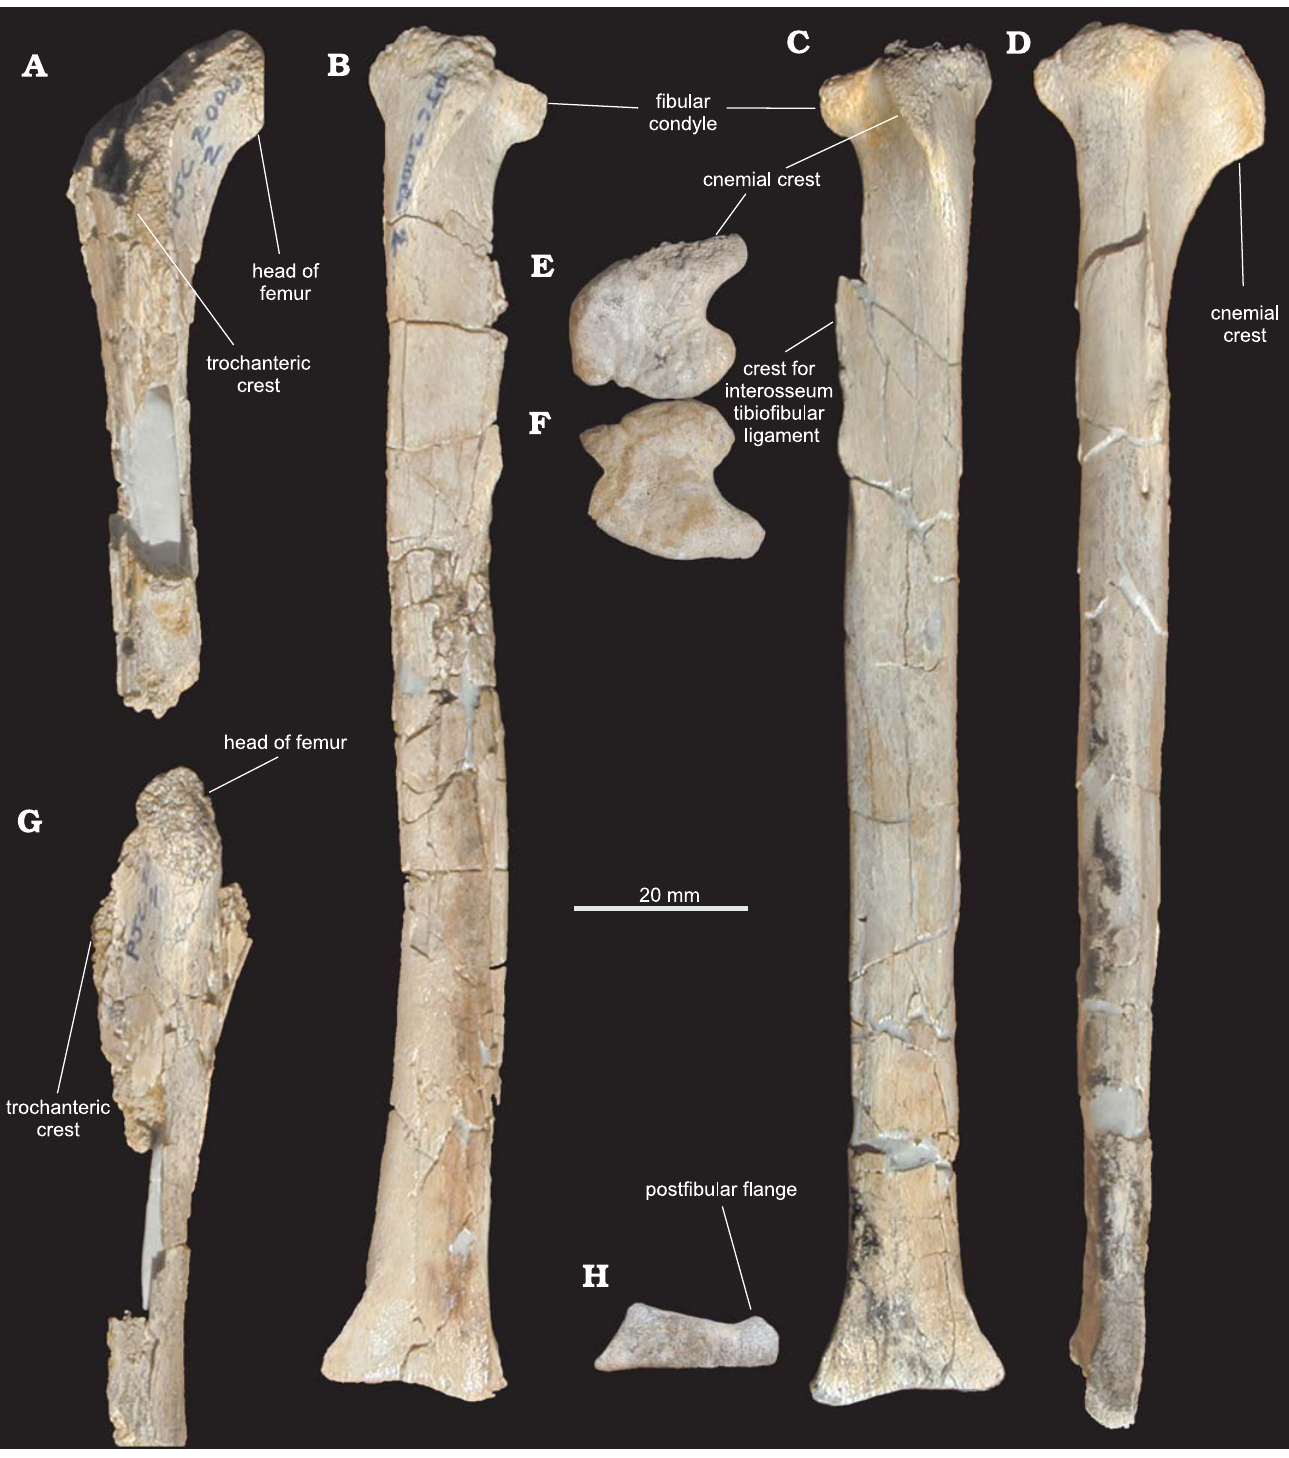
Fig. 6. Crested theropod dinosaur Elmisaurus rarus Osmólska, 1981, MPC-D 102/007 from Nemegt Formation (Upper Cretaceous), Western Sayr of Nemegt locality, Mongolia. Proximal head of femur in anterior ( A ) and medial ( G ) views. Tibia in anterior ( B , C ), proximal ( F ), distal ( H ), and lateral ( E , D )